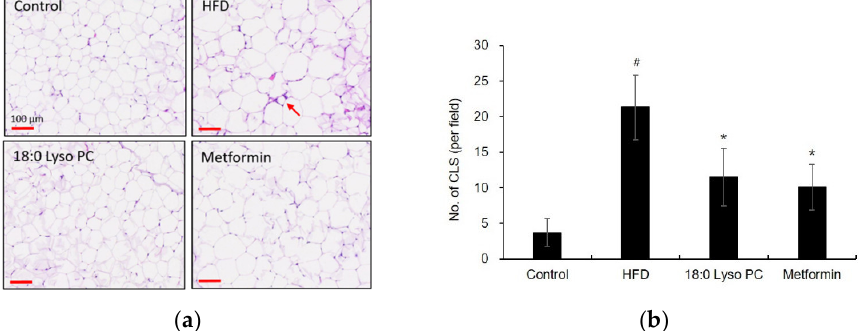
Figure 6. The effect of 18:0 Lyso PC on adipose tissue macrophage infiltration. ( a ) Hematoxylin and eosin (H&E) stained images for crown-like structure (CLS) from different group (scale bar, 100 μm), the arrows indicate CLS, ( b ) the quantification of CLS in adipose tissue (counts CLS per field; scale bar, 100 µ m). The results are presented as mean ± SD ( n = 6). Significant differences were identified at # p < 0.005, the control group vs. the high-fat diet (HFD) group; * p < 0.005, the HFD group vs. the treatment